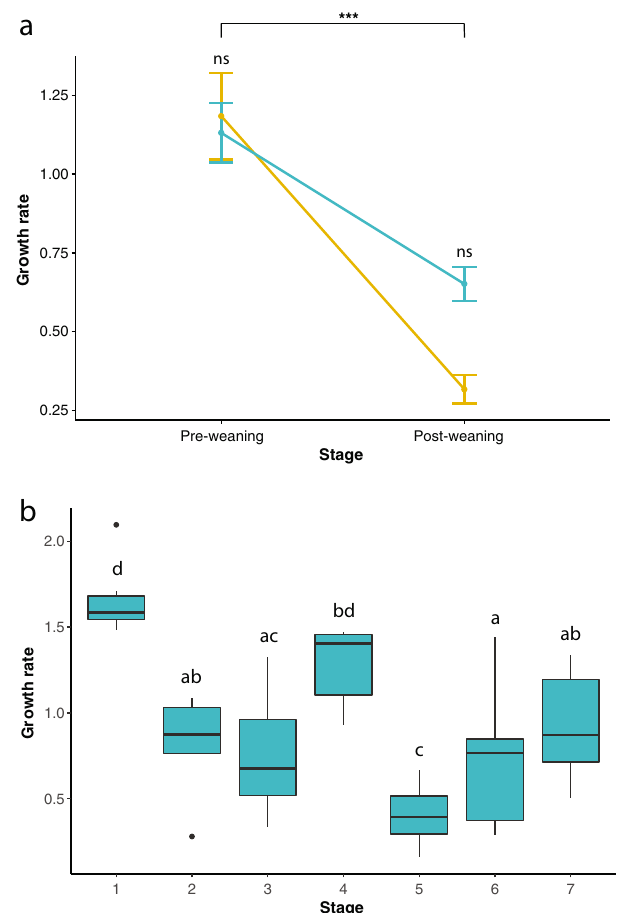
Figure 2. Average growth rates of the six bones analysed (in mm 2 /day) ( a ) for the pre- and post-weaning stages of calves nursed by their mothers (C1; orange colour, means ± standard errors of means) and hand raised calves (C2; blue colour) and ( b ) for the seven growth stages of hand-raised specimens (C2; blue colour). ( b ) Box plots of growth rates of C2 individuals with finer resolution of time (stage 1: birth–3 days; stage 2: 3–15 days, stage 3: 3–30 days; stage 4: 30 days–13 weeks; stage 5: 13–15 weeks; stage 6: 15–17 weeks and stage 7: 17–23 weeks). In graph ( a ), ns: no significant differences. In graph ( b ), different letters above each point indicate significant differences (when groups show different letters) and non-significant differences (when groups share a letter) between groups according to Tukey post-hoc comparisons (p <